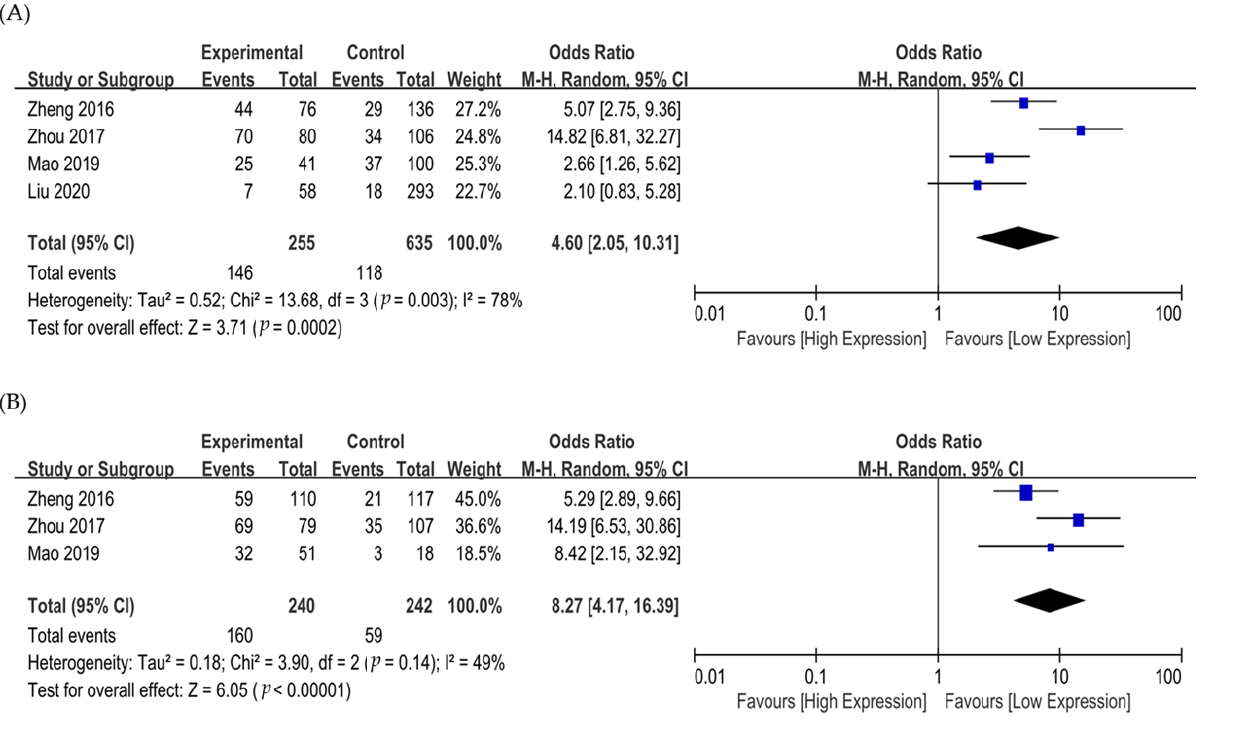
Figure 4. Forest plot of odds ratio for ( A ) advanced stages (I/II vs. III/IV) and ( B ) lymph node me- tastasis.